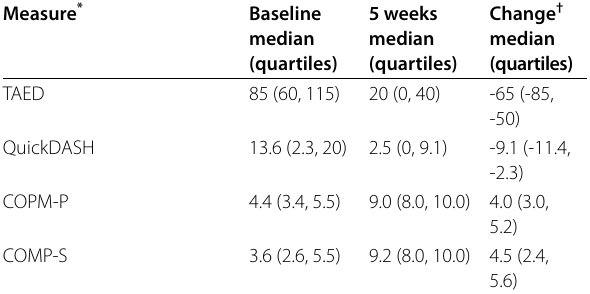
Table 4 Active extension deficit (degrees) in treated finger joints, and scores for the QuickDASH and